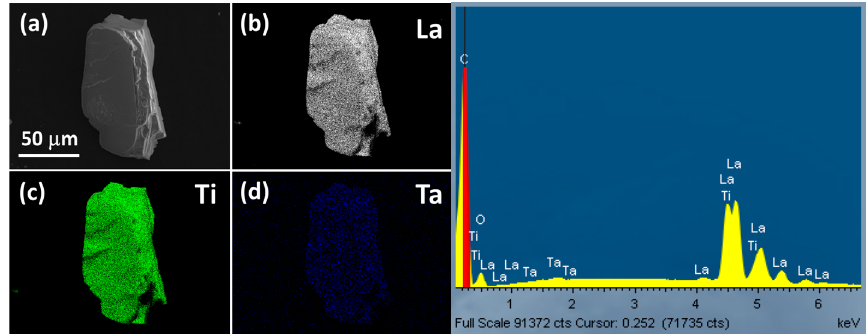
Figure 4. EDX images of Ta-LTO single crystal. ( a ): Ta-LTO ( b ): La ( c ):Ti ( d ):Ta.